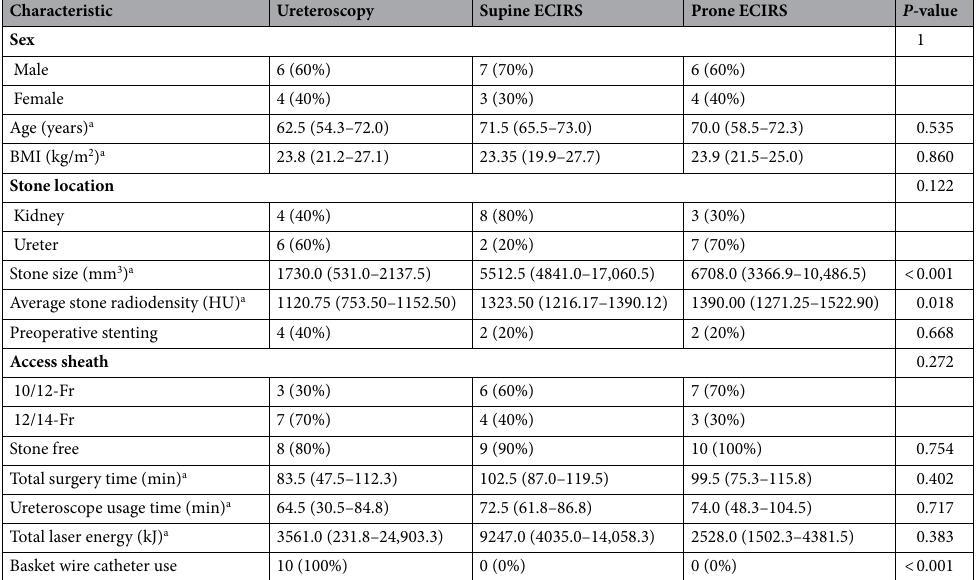
Table 1. Patient characteristics. ECIRS endoscopic combined intrarenal surgery, BMI body mass index, HU Hounsfield units, CT computed tomography. a Median (interquartile range).